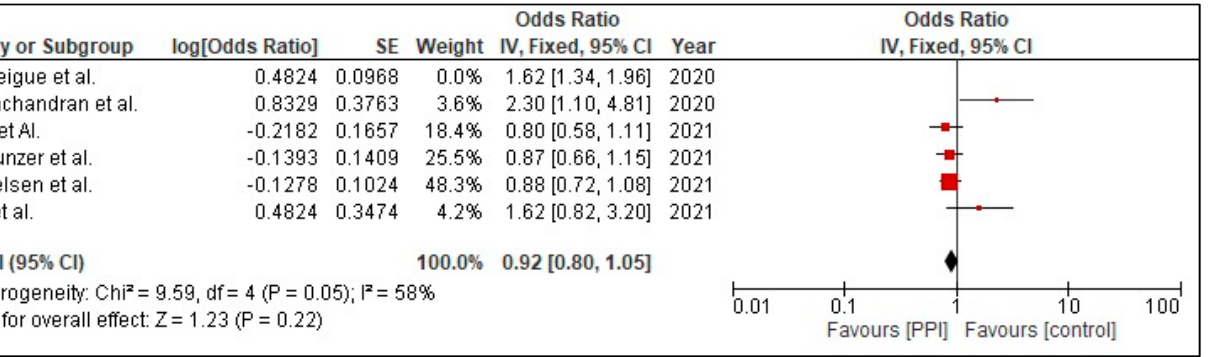
Figure 5. Risk mortality in patients with COVID-19 on PPI versus not on PPI after sensitivity anal- ysis.